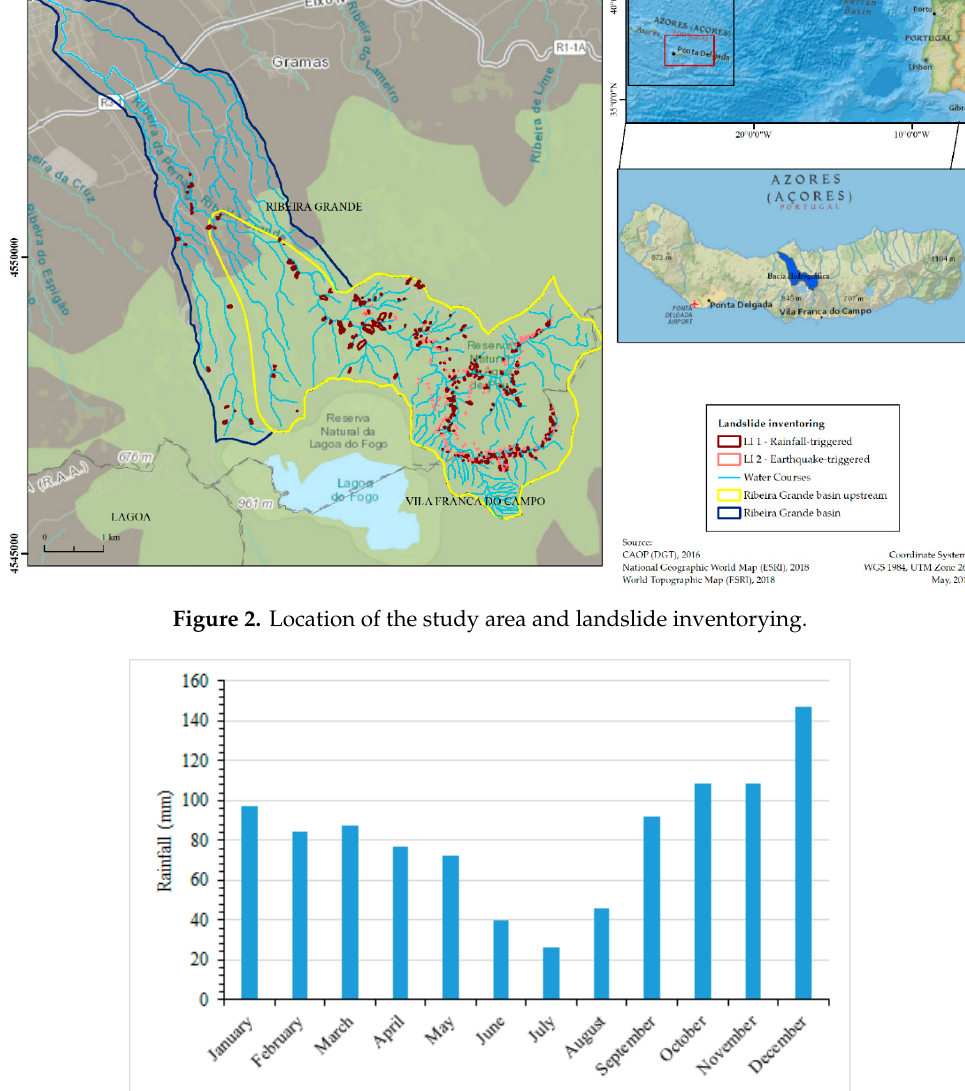
Figure 3. Average Monthly Rainfall (mm). Meteorological station of Ponta Delgada (normal climatological, 1981–2010. Source: Portuguese Institute of the Sea and Atmosphere, 2017.